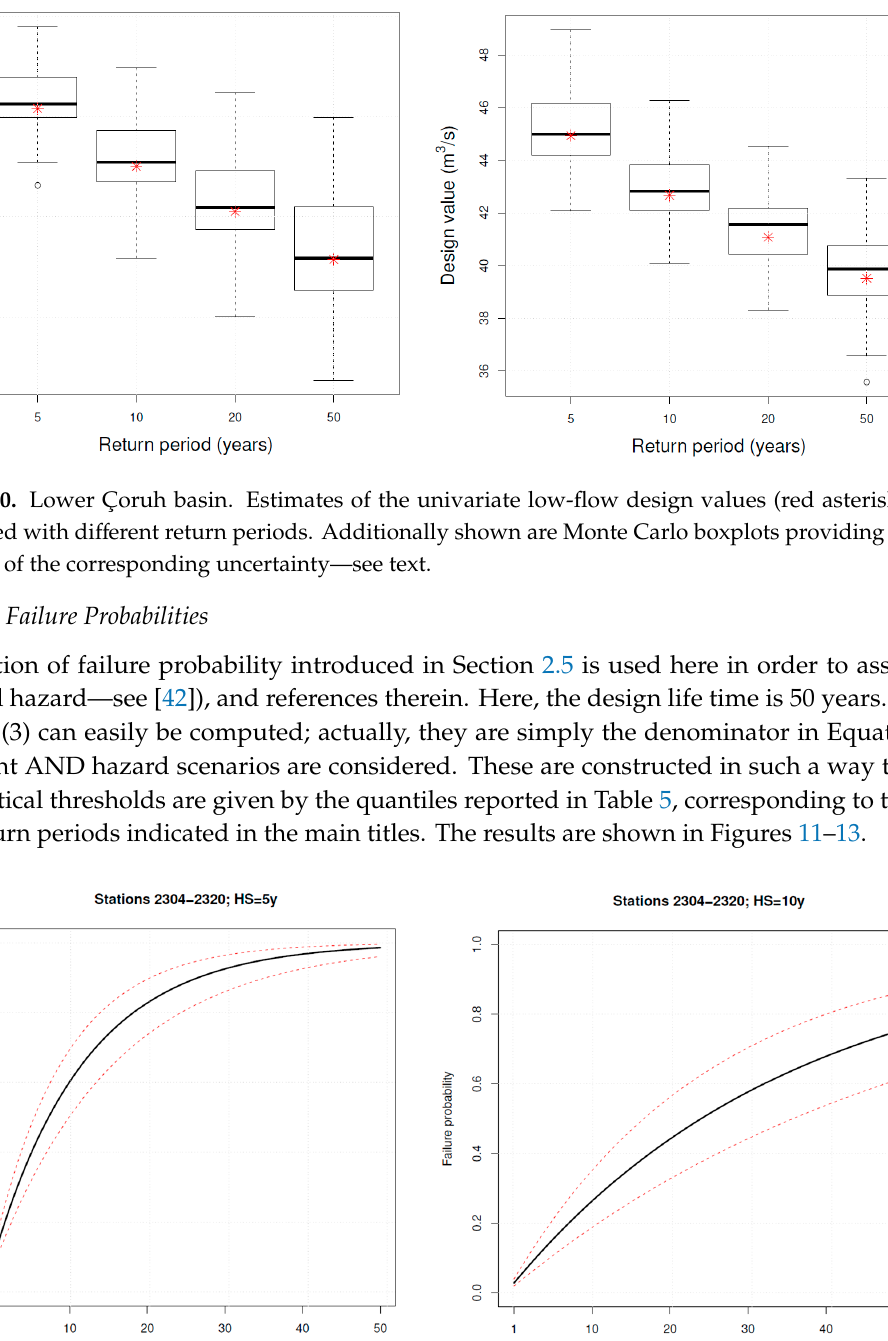
Figure 11. Upper Çoruh basin. Failure probabilities for given design life times; the dashed red lines indicate a 95% confidence band. The different plots correspond to the probability that the system enters a bivariate AND hazard scenario whose marginal critical thresholds are given by the quantiles reported in Table 5, corresponding to different return periods indicated in the main titles—see text.